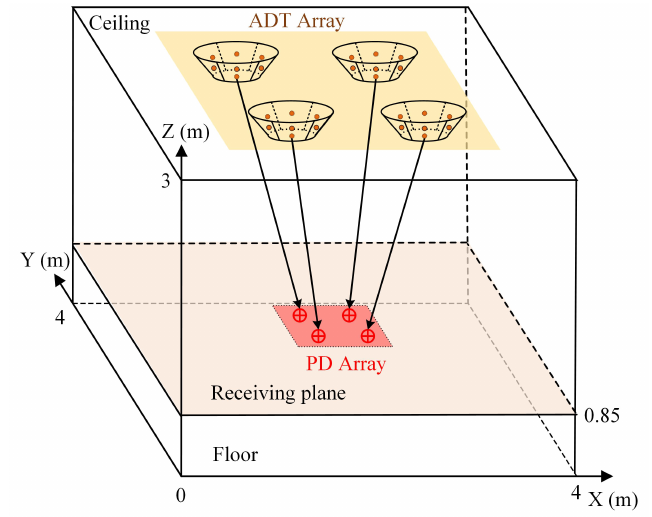
Figure 1. Geometric setup of a general MIMO-VLC